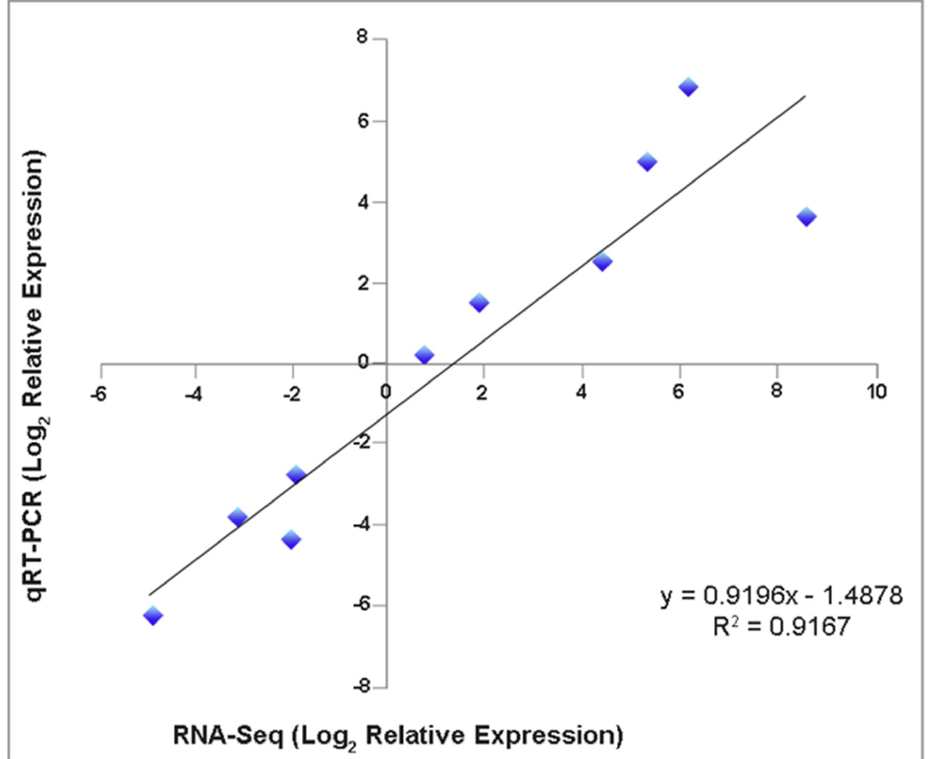
Figure 6. Expression level correlation from RNA–seq analysis and reverse transcription followed by quantitative real-time PCR (RT–qPCR). Ten randomly selected DETs were compared by both techniques (three biological replicates). The EF2 ( Translation Elongation Factor 2 ) gene was used as an internal control.